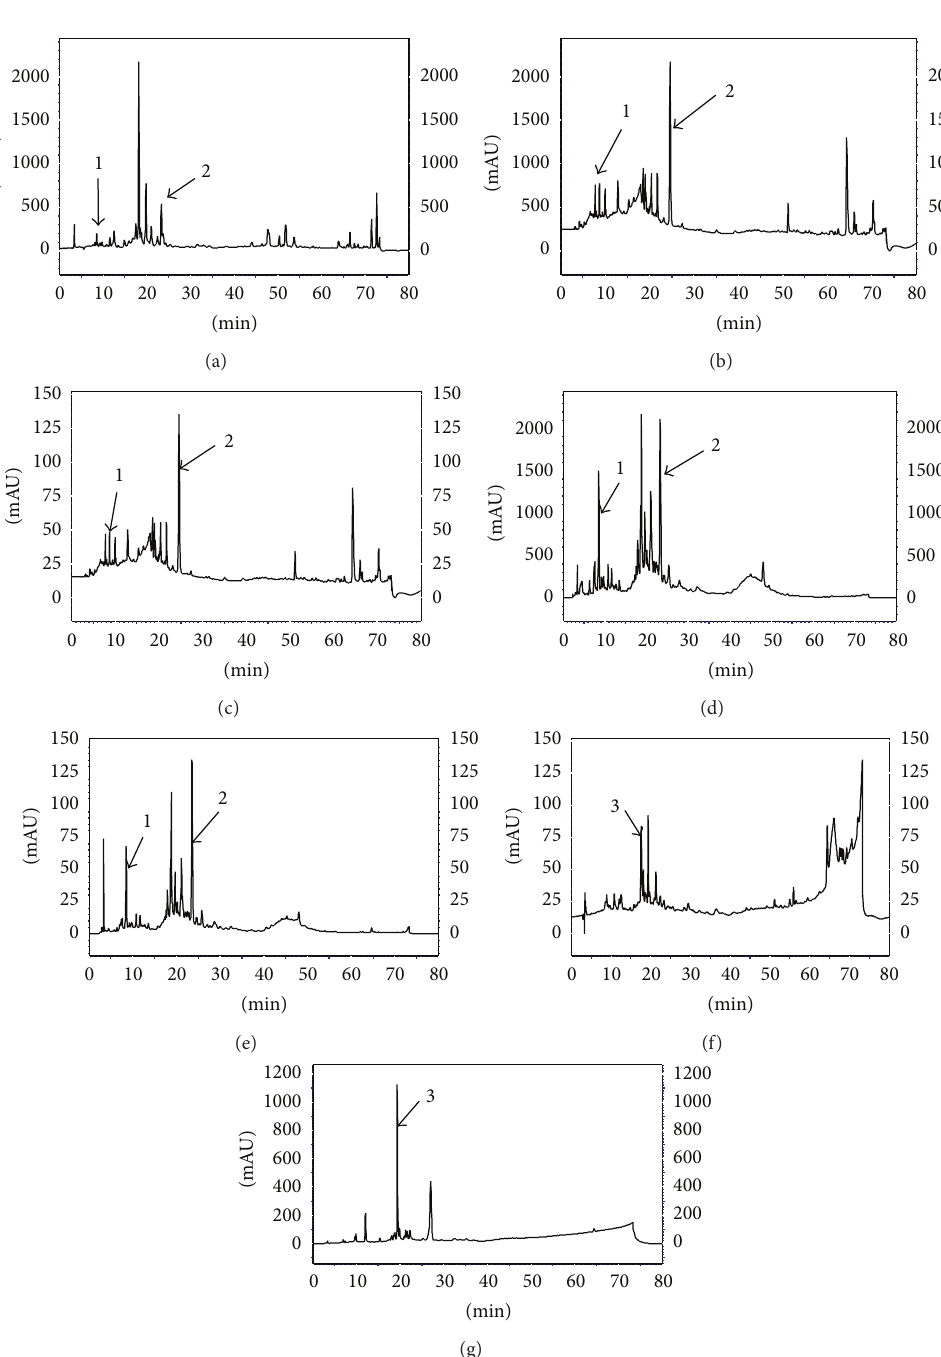
Figure 2: Representative HPLC chromatograms of chetoui O. europaea variety extracts. (a) Stems ethyl acetate extract. (b) Stems methanol extract. (c) Leaves ethyl acetate extract. (d) Leaves methanol extract. (e) Leaves methanol water extract. (f) Nuts ethyl acetate extract. (g)